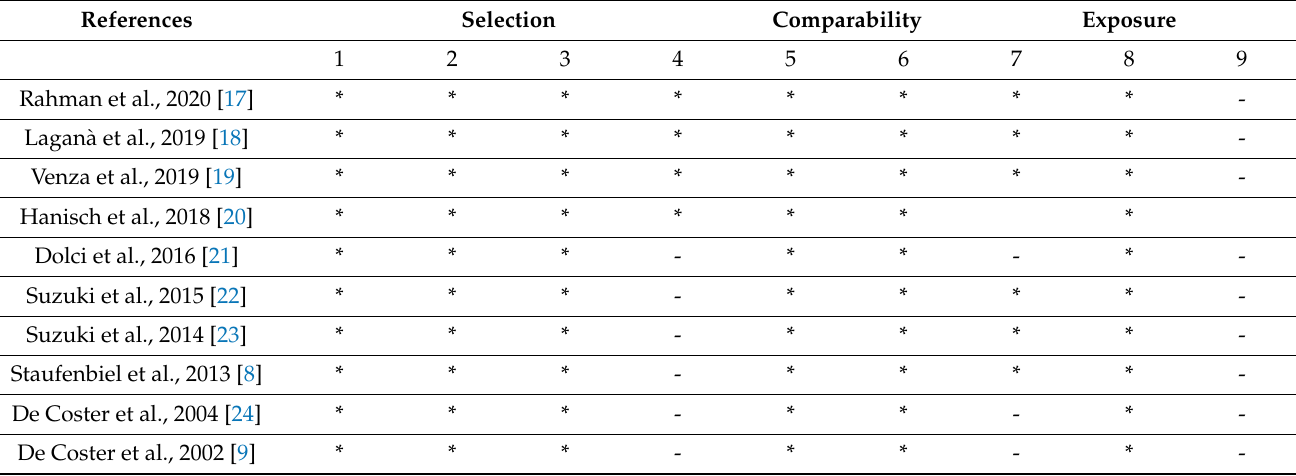
Table 2. Methodological quality assessment of the studies by Newcastle–Ottawa Quality Assessment Scale (NOS).